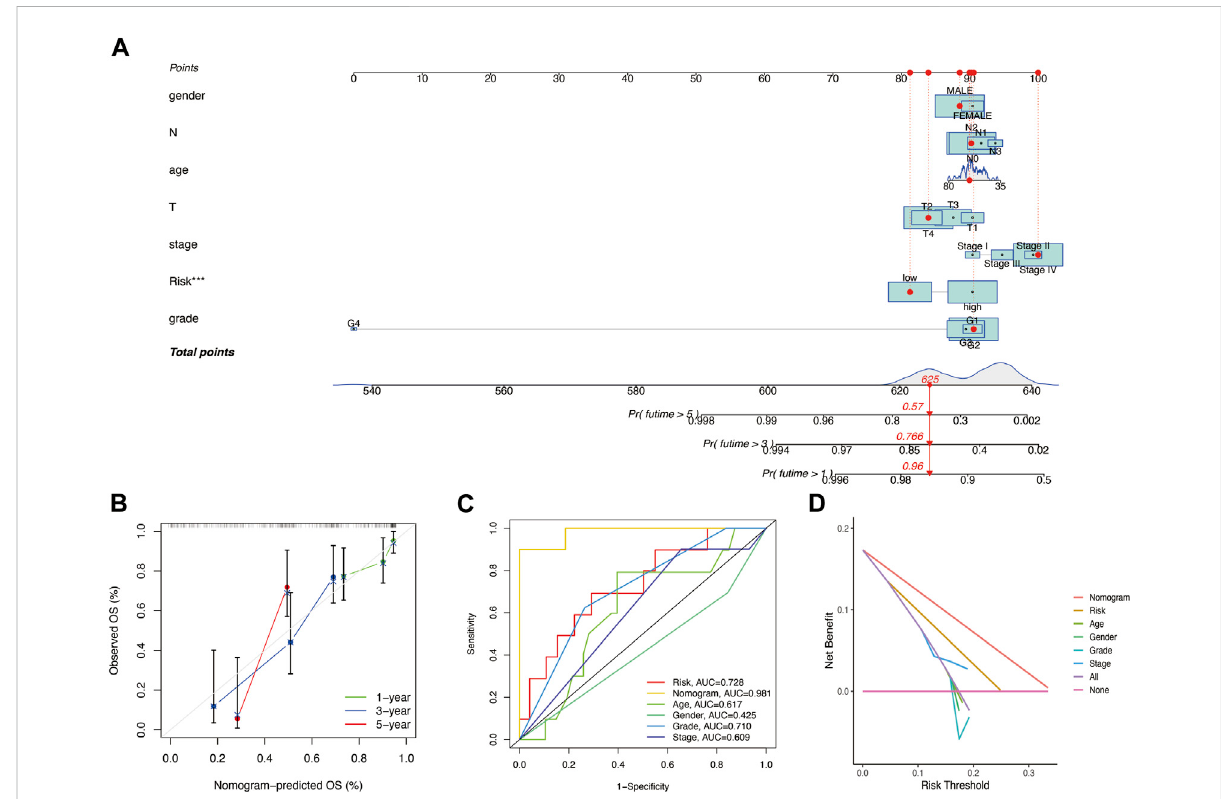
FIGURE 6 (A) Nomogram for predicting the OS of HNSCC patients. For each patient, lines are drawn downward to assess the points received from the sevenprognosticfactorsinthenomogram.Thesumofthesepointsisshownonthe “ Totalpoints ” axis.Alineisdrawndownwardtodeterminethe1-, 3-, and 5-year OS of HNSCC patients. (B) Calibration plot for the internal validation of the nomogram. The Y -axis exhibits actual survival. The X -axis exhibitsnomogram-estimatedsurvival.Thedottedline(45 ° diagonalline)signi fi esfullagreementbetweenactualandobservedprobabilities. (C) Comparison of the AUC values of the nomogram and risk score, age, gender, grade, and stage. (D) Clinical net bene fi t of the nomogram, risk score, and other clinical features (including age, gender, grade, and